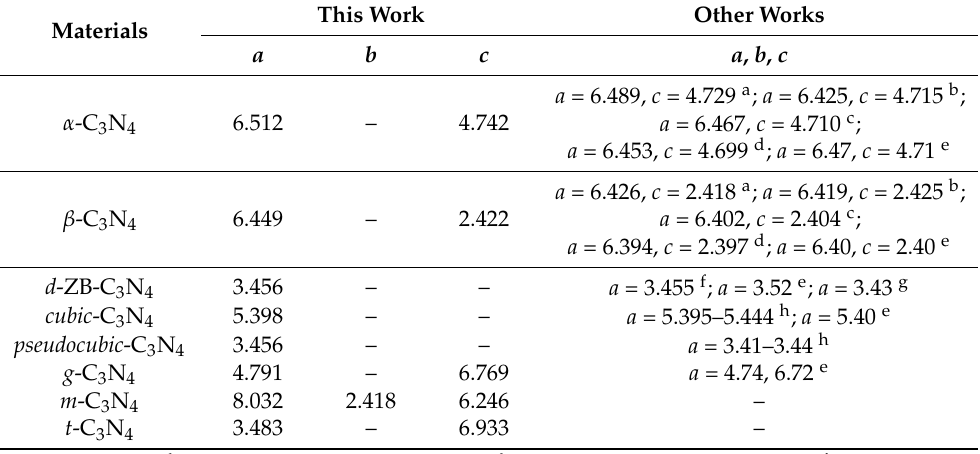
Figure 1. The crystal structures of: m -C 3 N 4 ( a , b ); and t -C 3 N 4 ( c ) (black spheres denote carbon atoms, blue spheres denote nitrogen atoms). Table 1. Calculated lattice parameters (Å) of m -C 3 N 4 , t -C 3 N 4 , d -ZB-C 3 N 4 , Cubic -C 3 N 4 , Pseudocubic -C 3 N 4 and g -C 3 N 4 .